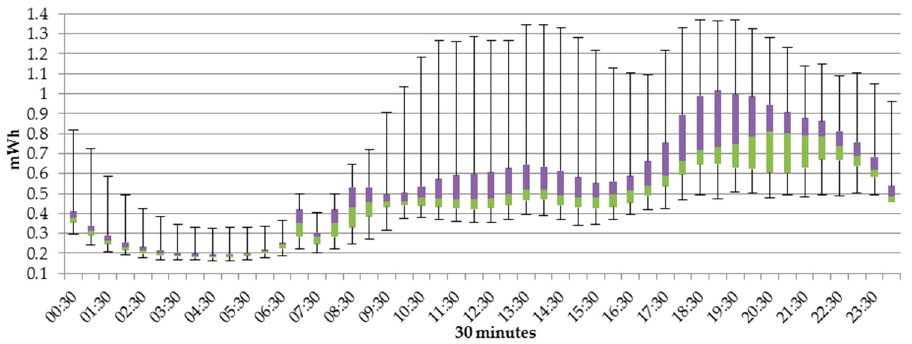
Figure 5. Thirty-minute consumption volatility in the analyzed period (15 July 2009–31 December